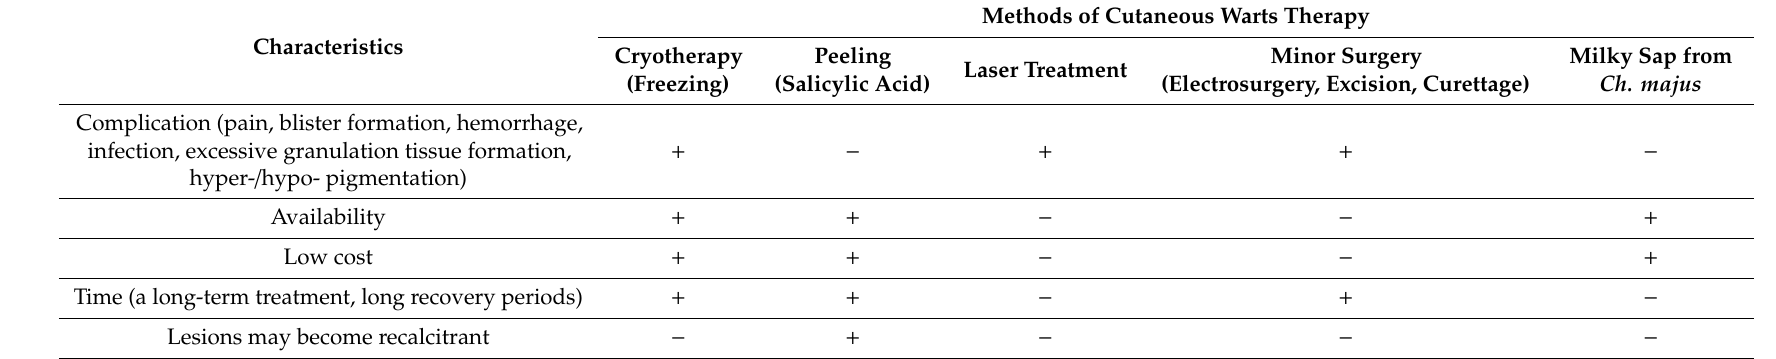
Table 1. Comparison of various conventional treatments of cutaneous warts and milky sap from Ch.